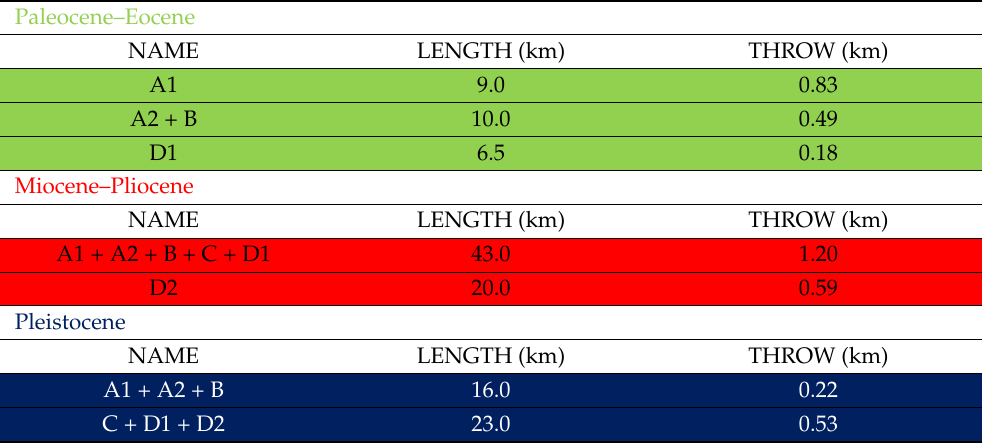
Table 1. Name, length, and vertical throw of the computed fault segments related to the Paleocene– Eocene (green), Miocene–Pliocene (red), and Pleistocene (blue) fault segments.